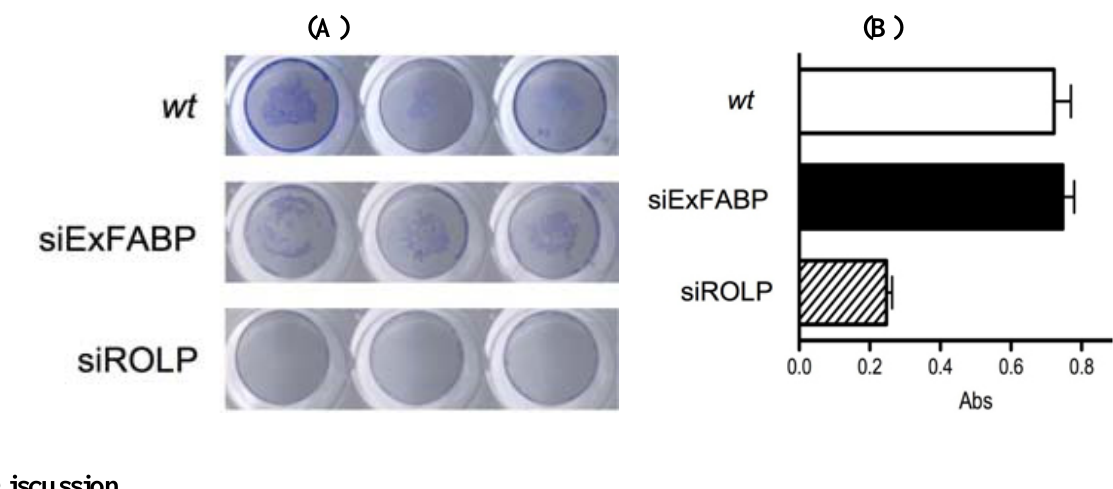
Figure 4. Cell adhesion properties assay of wt -NIH3T3, siEXFABP-NIH3T3 and siROLP-NIH3T3 cells. Viable, adherent cells were stained with methylene blue (A) or MTT (B) immediately after the adhesion essay. The bars represent the mean 